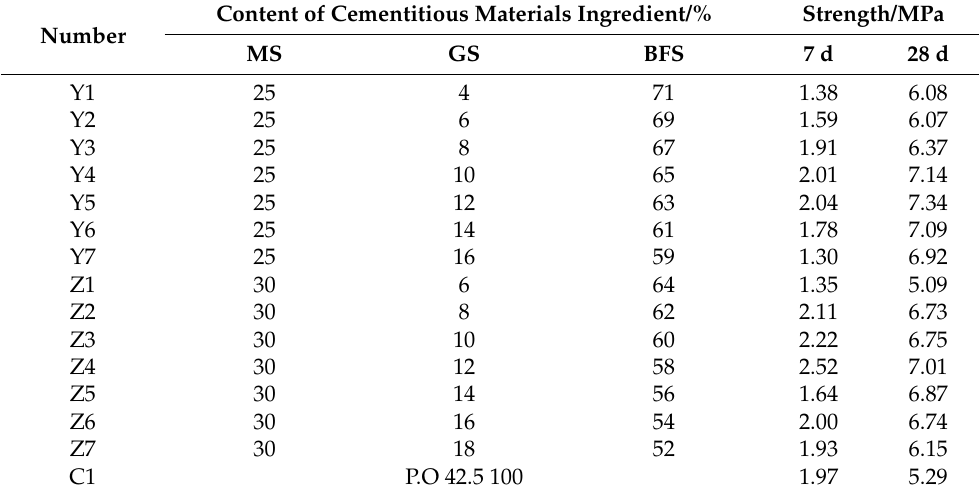
Table 3. Strength of samples prepared with